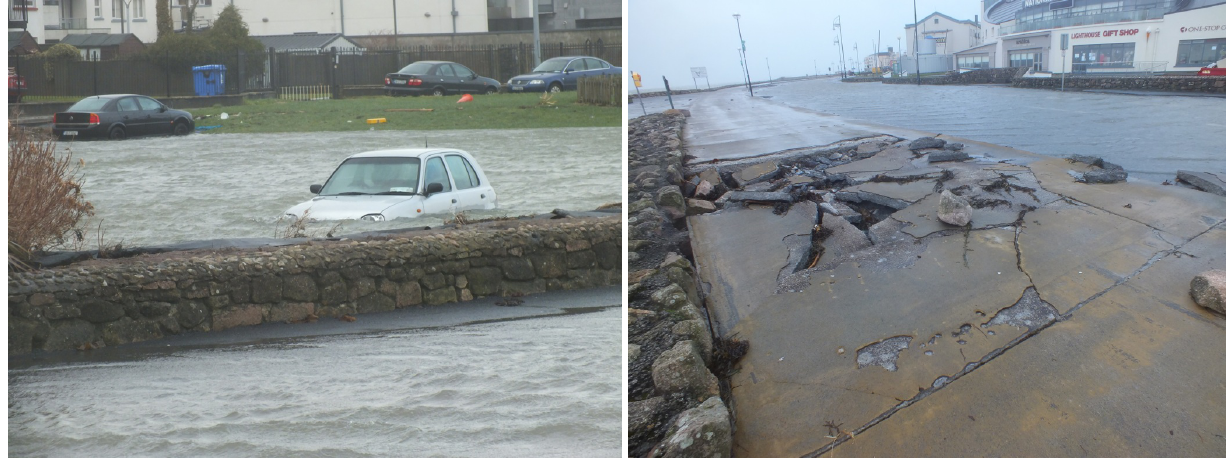
Figure 18. Photos of Galway on 1 February 2014 (credit: Emiliano Renzi)